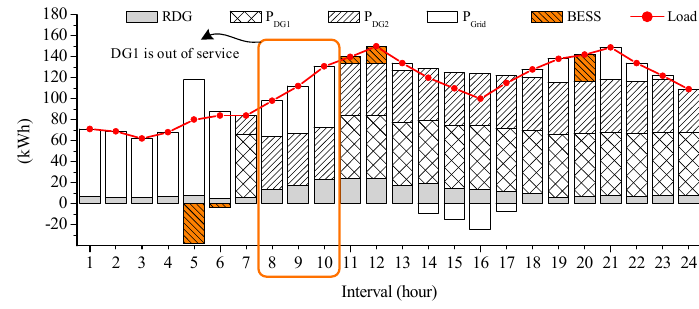
Figure 9. Schedule for all components considering the events at 8 h and 10 h.